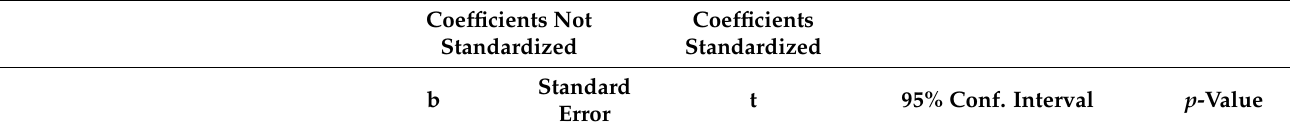
Table 5. Results of the linear multiple regression analysis